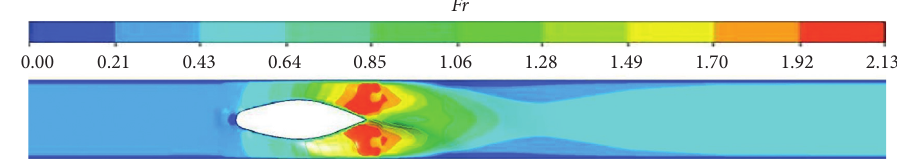
Figure 8: The distribution of the Froude number in the portable pillar-shaped flume.